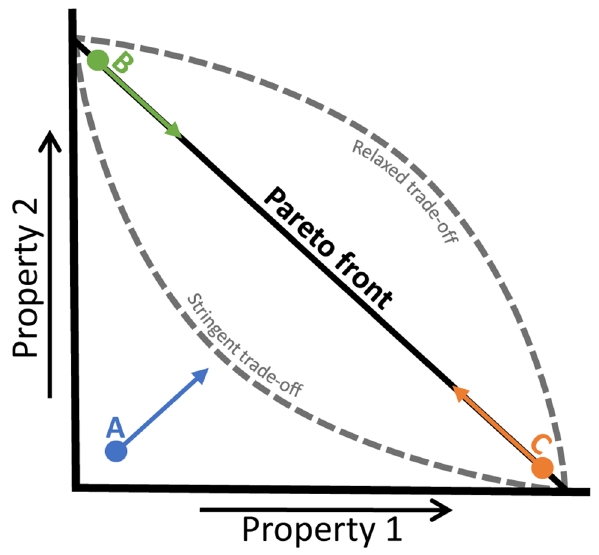
Figure 9. A trade-off between two cellular or molecular properties can be visualised as an apparent Pareto front (black line). When neither of the properties is maximized (point A), increases in both can be achieved (blue arrow). When for example property 2 has been fully optimized (point B), optimization of property 1 will require a reduction in property 2 (green arrow) and vice versa (orange arrow from point C). The more stringent the trade-off is, the more concave the Pareto front will become (lower dashed line), while if the trade-off is more relaxed, it can become convex (upper dashed